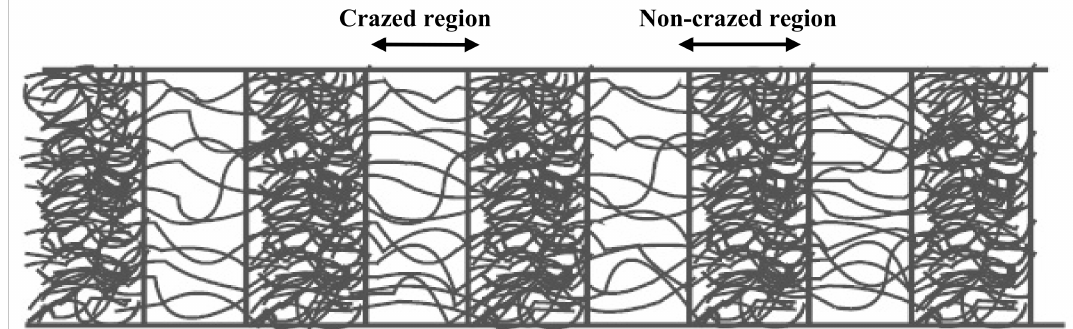
Figure 4. An illustration of fibrous and porous network strain that formed during the crazing